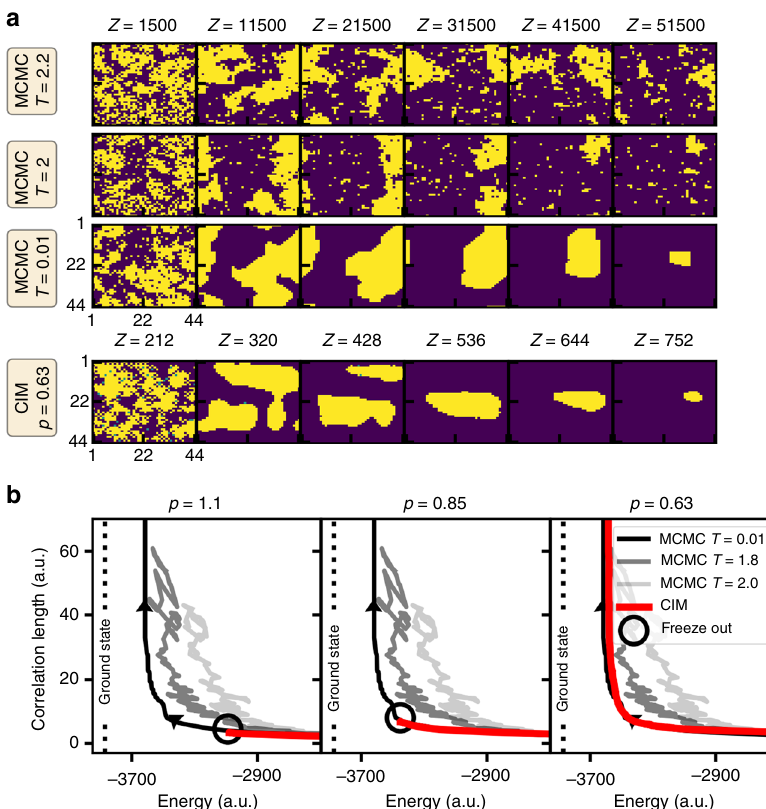
Fig. 4 Comparison of Monte Carlo simulation (MCMC) and coherent Ising machine (CIM) during the ground state search. a Snapshots of the spin con fi guration (blue: spin down, yellow: spin up) as it approaches the ground state obtained by Monte Carlo simulations (MCMC) at different temperatures T = {0.01, 2.0, 2.2} and by the CIM at p = 0.63. b Time evolution of energy and correlation length during the ground state search for both Monte Carlo simulations at different temperatures (black and gray lines) and the coherent Ising machine (red line) at pump amplitudes p = {1.1, 0.85, 0.63}. The arrows show the direction of the trajectories as the ground state is approached. Freeze-out points are indicated by black